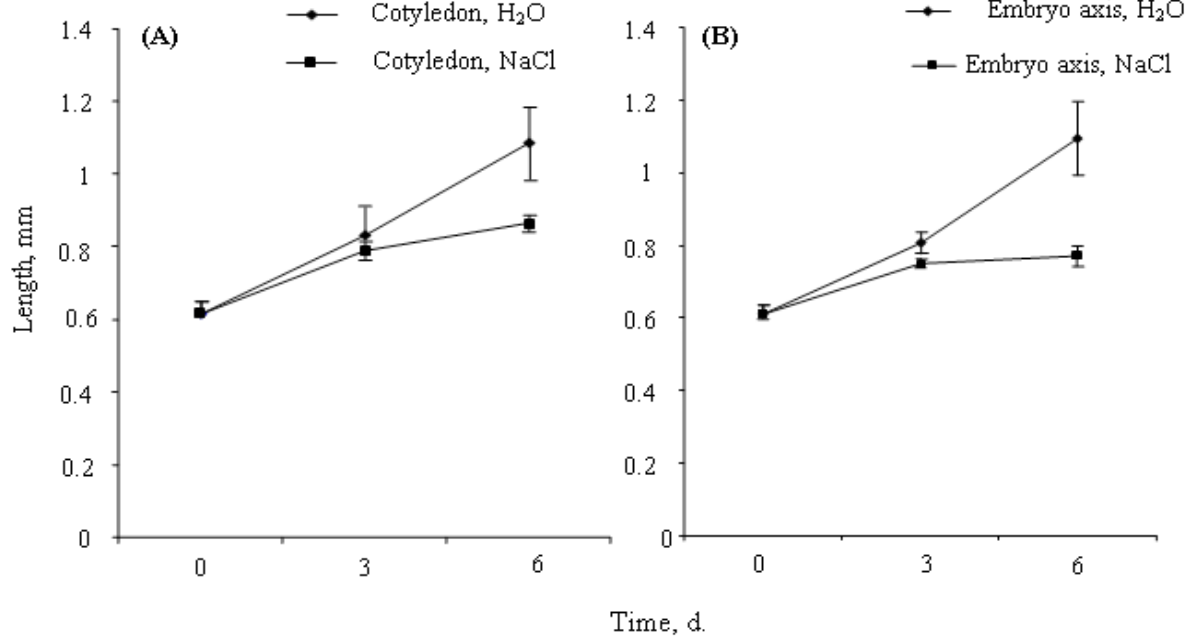
Fig. 2. C. maritimum L. embryo growth within the seeds, during imbibition in distilled water or 200 mM NaCl. (A) Cotyledon growth over time; (B) Axis growth over time; (means ±